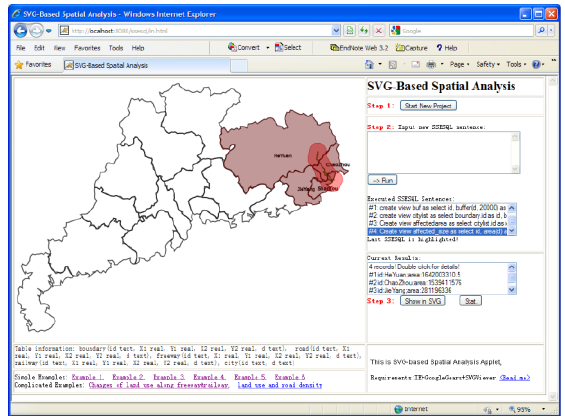
Figure 4. Listing all the administrative districts affected by river “R1”, and calculating their affected area size